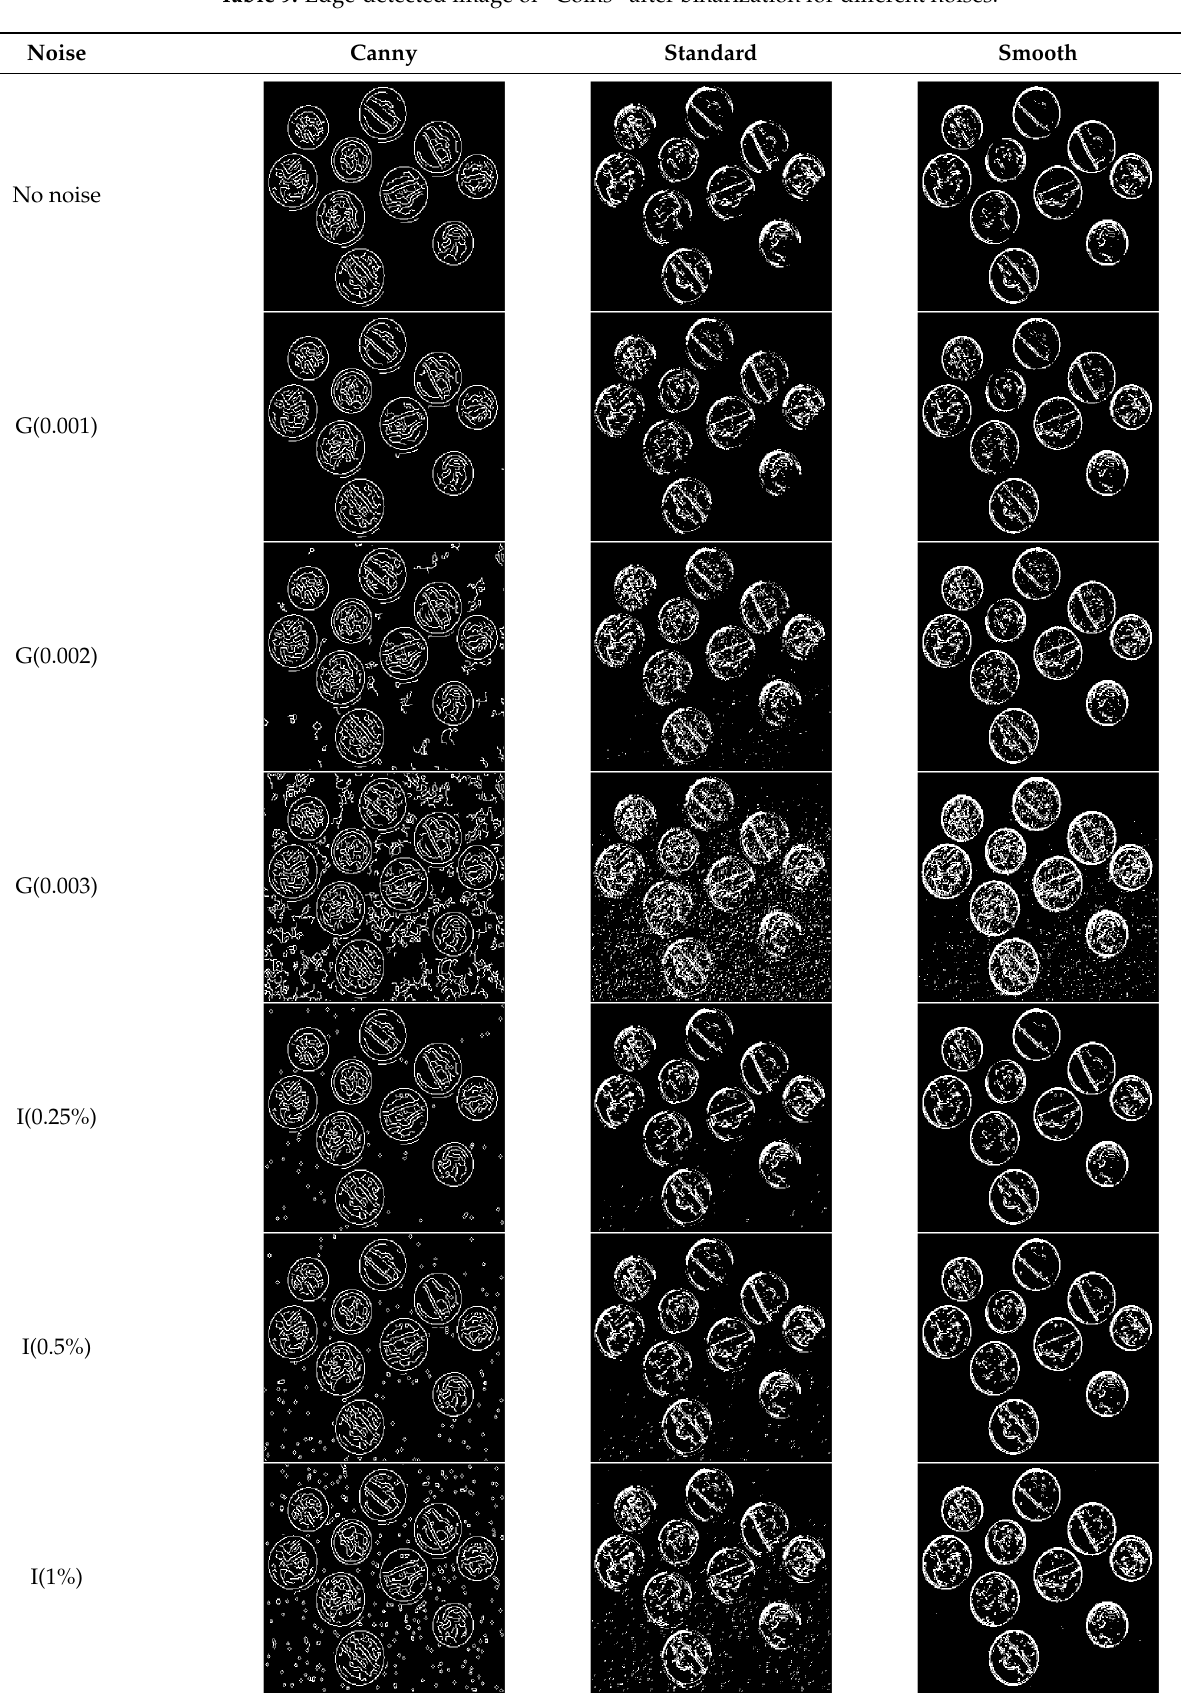
Table 9. Edge-detected image of “Coins” after binarization for different